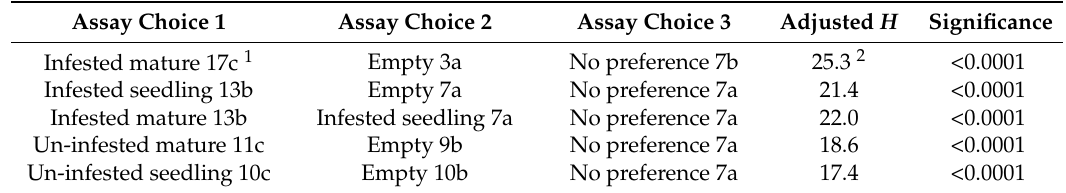
Table 3. Rhyzobius lophanthae adult search responses to Y-tube olfactometer volatiles within in-situ settings. Cumulative responses of 20 adults that made decisions within in-situ forest. N = 10